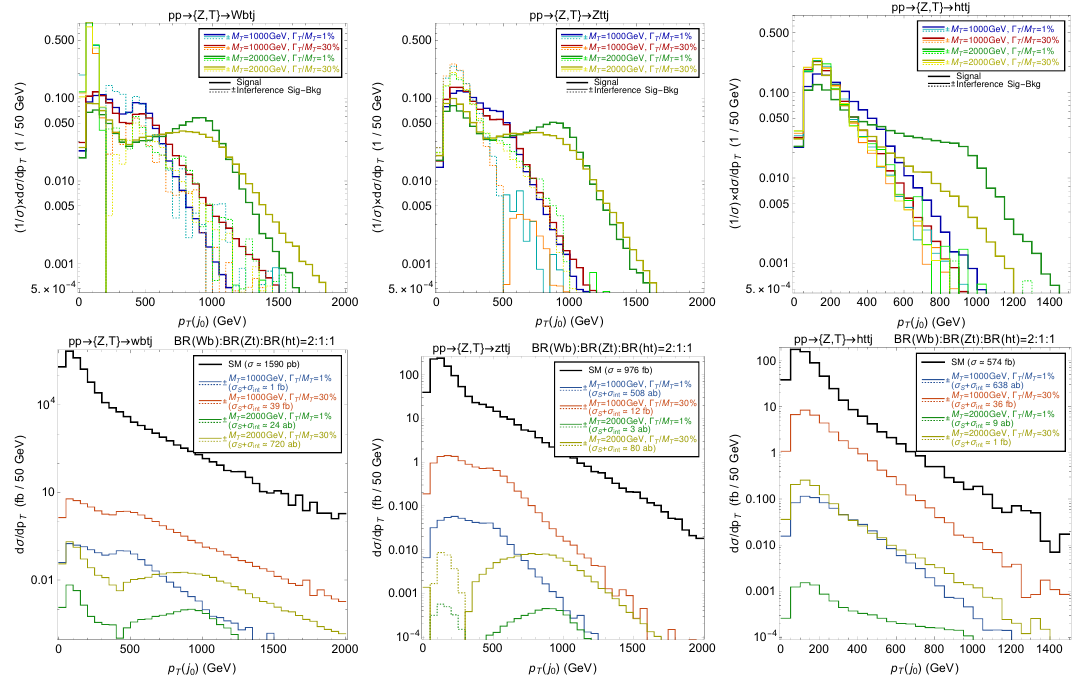
Figure 25 . Same as figure 24 for the p T of the leading jet.